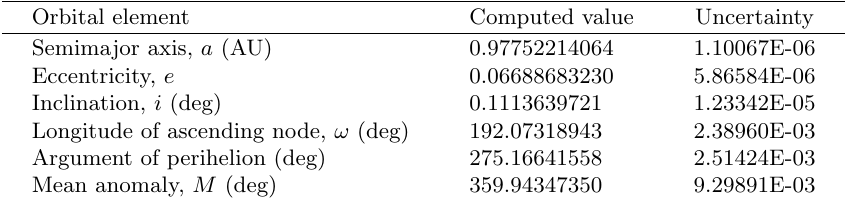
Table 1. Asteroid 2000 SG344. Keplerian orbital elements with their uncertainties for the epoch JD2457200.5 = 2015 June 27; 25 perturbing asteroids, RMS = 0 : 3852 ′′ , H = 24 : 788 mag.